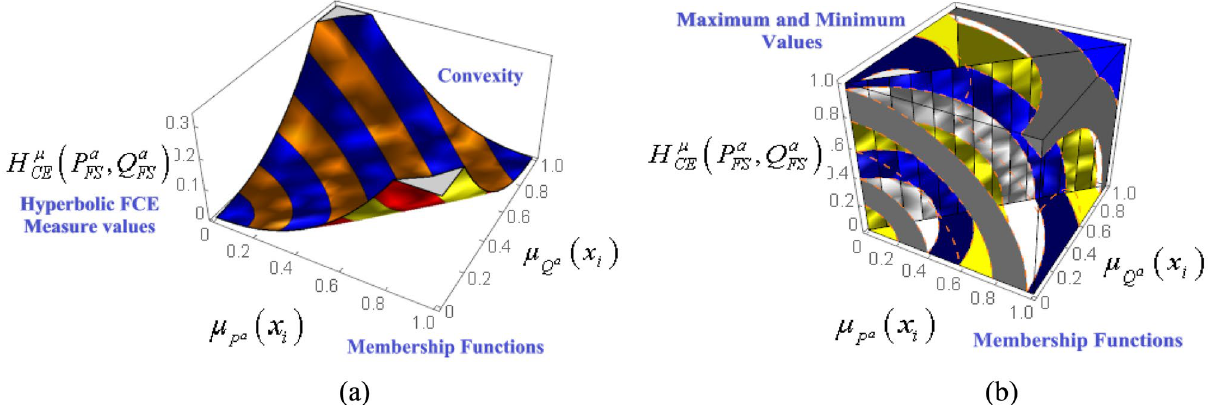
Figure 2. ( a ) Convexity property as indicated by H as attained by H